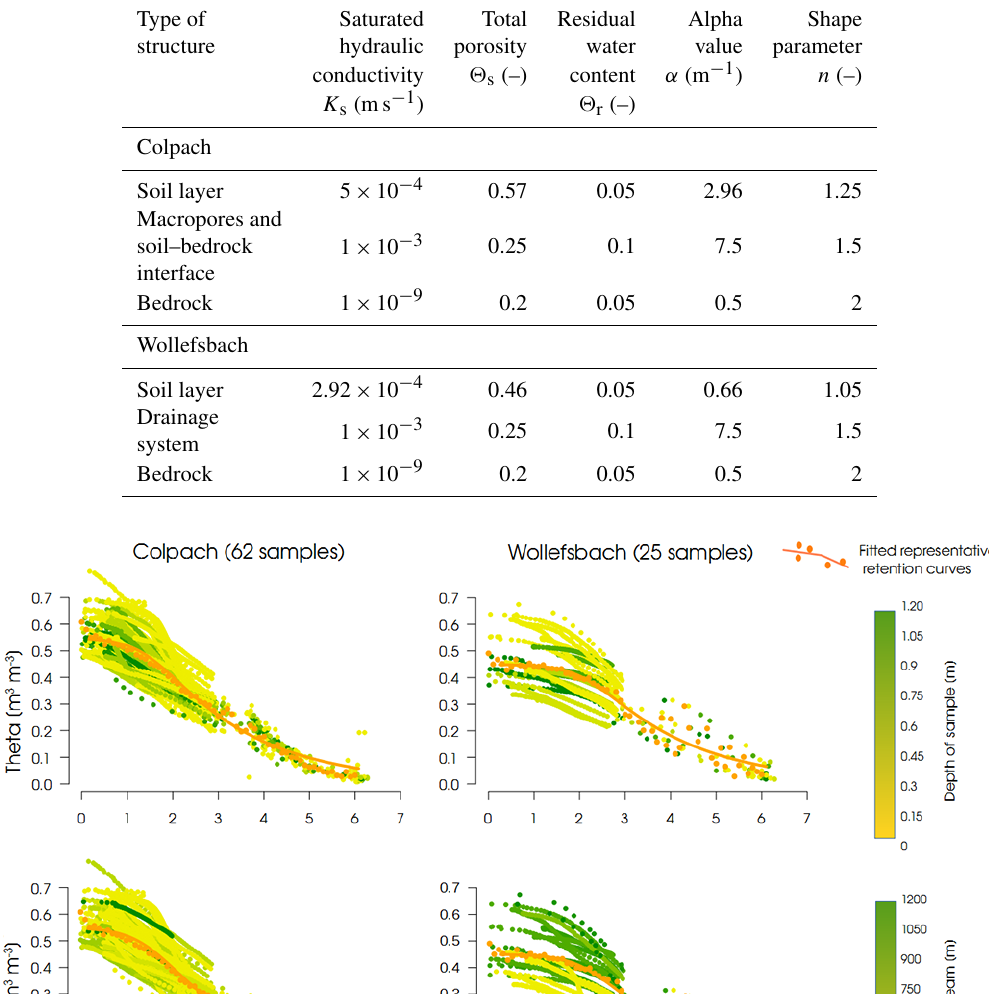
Table 1. Hydraulic and transport parameter values used for different materials in the model setups.